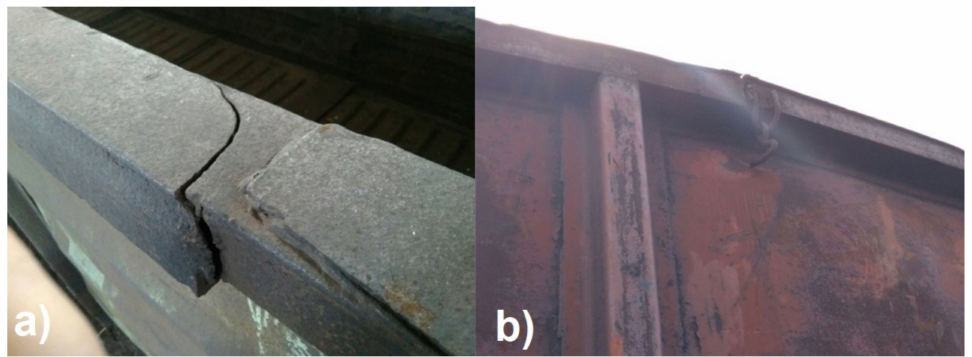
Figure 2. Damage to the top cord of a car body during unloading with a grab ( a ) crack in the top cord; ( b ) rupture in the top cord.